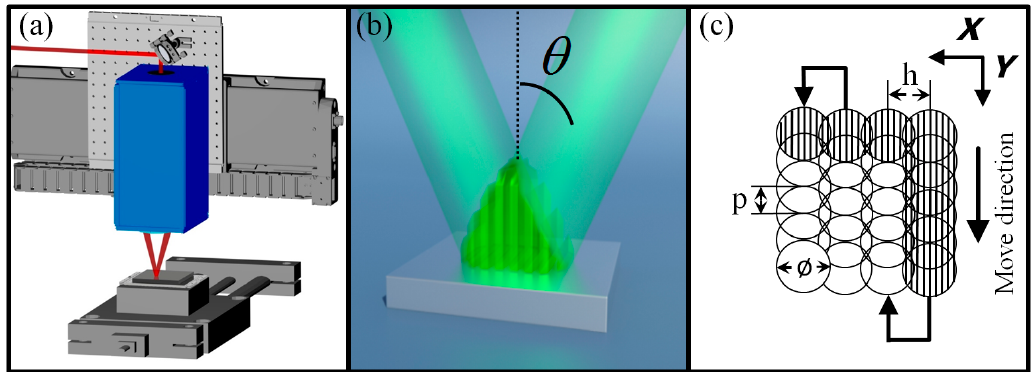
Figure 1. ( a ) Schema of the used two-beam direct laser interference patterning (DLIP) setup including the DLIP module and the translational stages; ( b ) Representation of a two-beam interference pattern at the materials surface; ( c ) Strategy utilized to process the samples: ø, h and p denote the diameter of the interference area, the hatch distance and the pulse-to-pulse overlap, respectively.